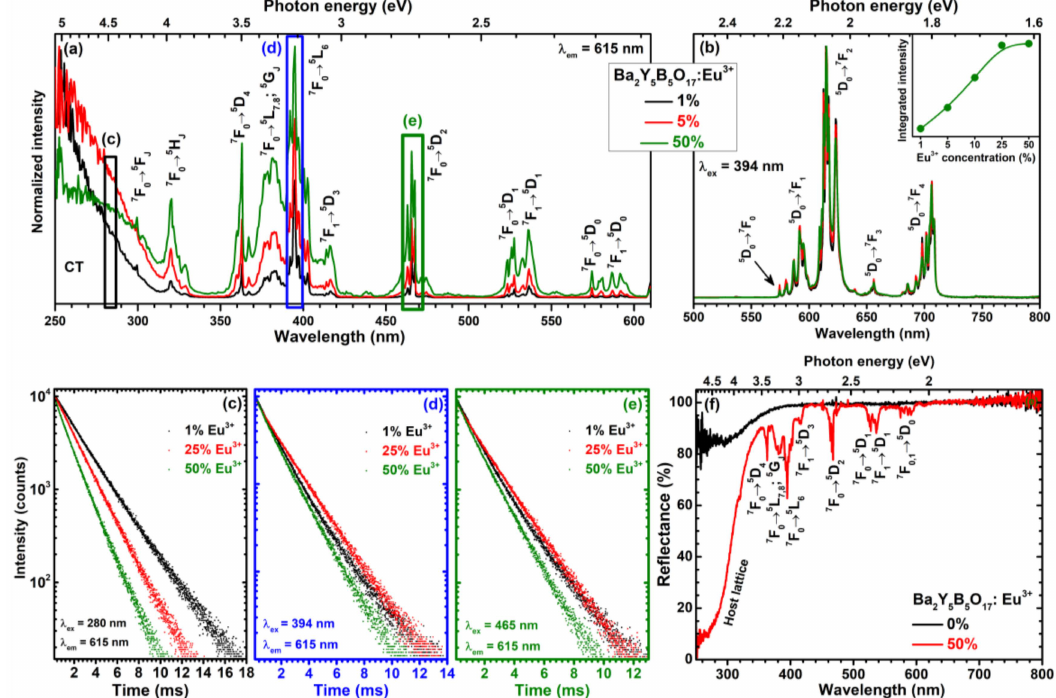
Figure 4. Eu 3 + concentration dependent excitation ( λ em = 615 nm) ( a ) and emission ( λ ex = 394 nm) ( b ) spectra of Ba 2 Y 5 B 5 O 17 :Eu 3 + phosphors. Inset in ( b ) shows integrated emission intensity as a function of Eu 3 + concentration. PL decay curves ( λ em = 615 nm) of samples doped with 1%, 25%, and 50% Eu 3 + recorded under di ff erent excitation wavelengths: 280 nm ( c ), 394 nm ( d ), and 465 nm ( e ). Reflection spectra of undoped and 50% Eu 3 + -doped Ba 2 Y 5 B 5 O 17 specimens ( f